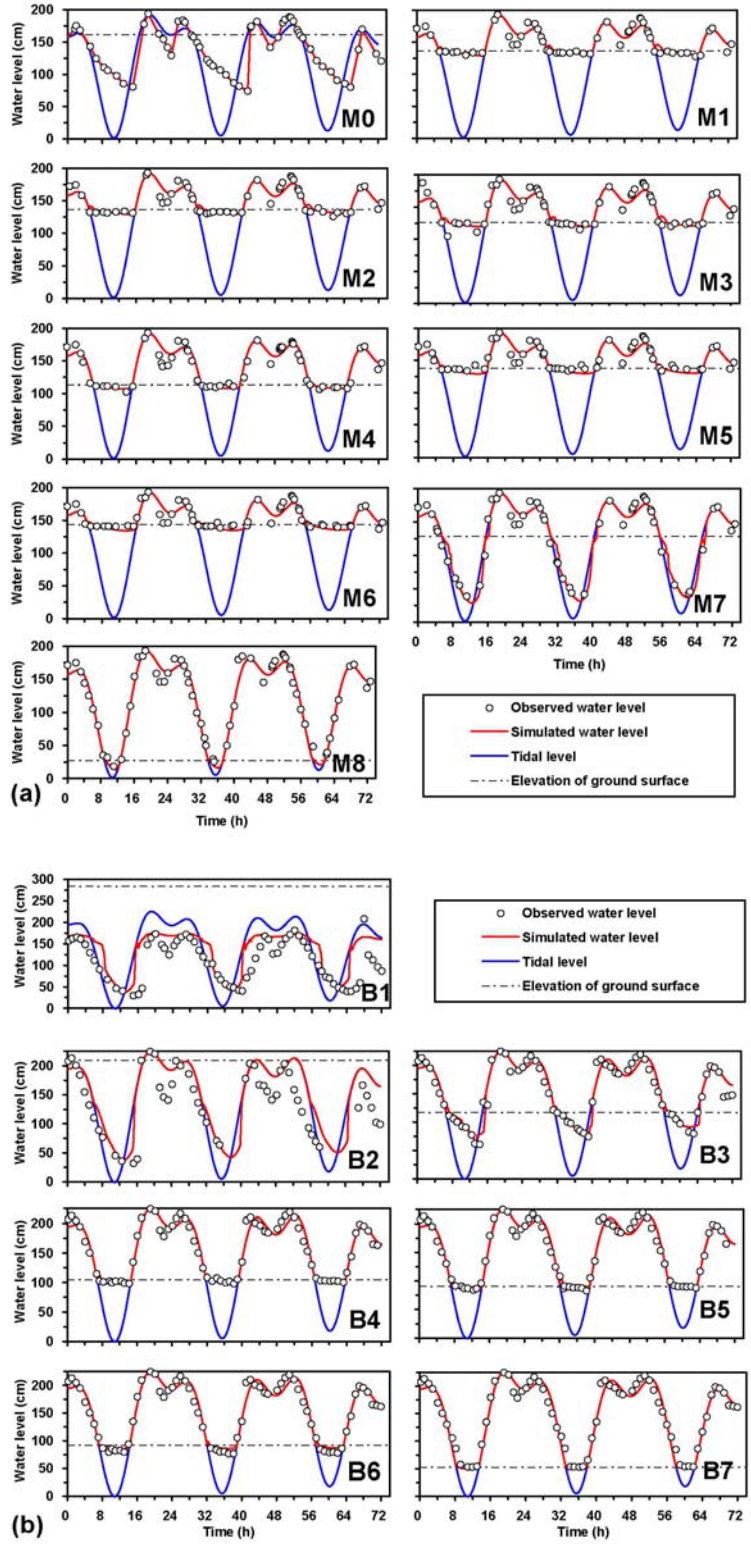
Fig. 7. Simulated (red line) and observed (circles) water levels at wells along the (a) mangrove and (b) bald beach transects. The ground surface elevation (dash dot line) at each well and the tidal level (blue line) are also shown.